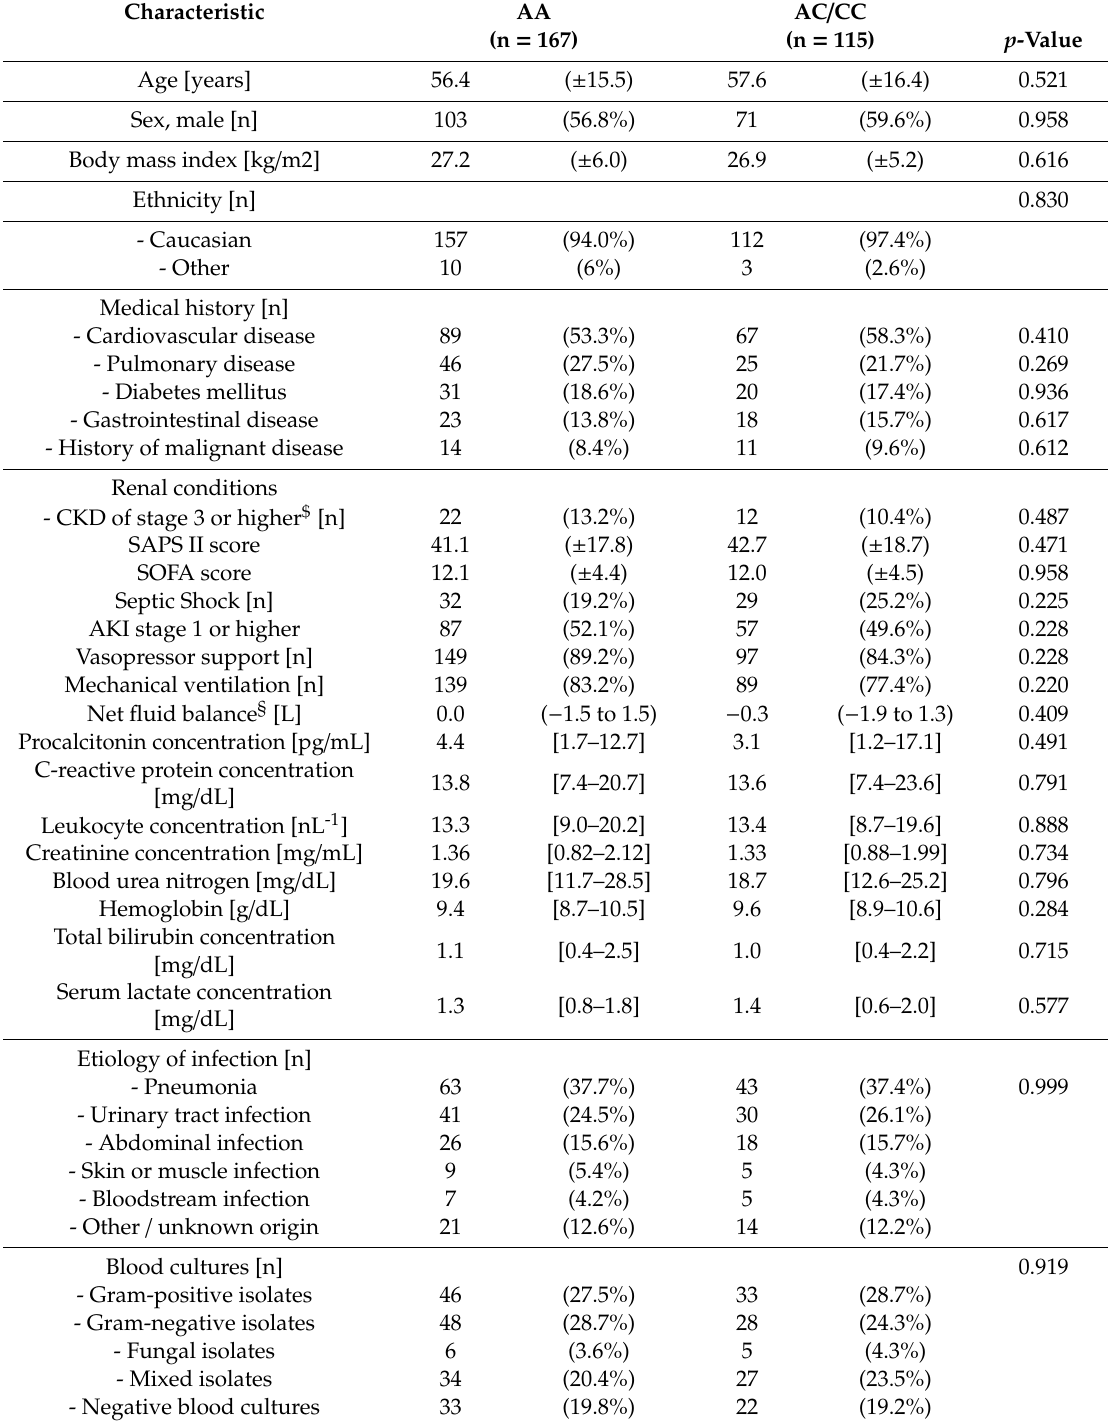
Table 1. Baseline characteristics of septic patients at baseline and stratified by AQP5 -1364A / C genotype (n =